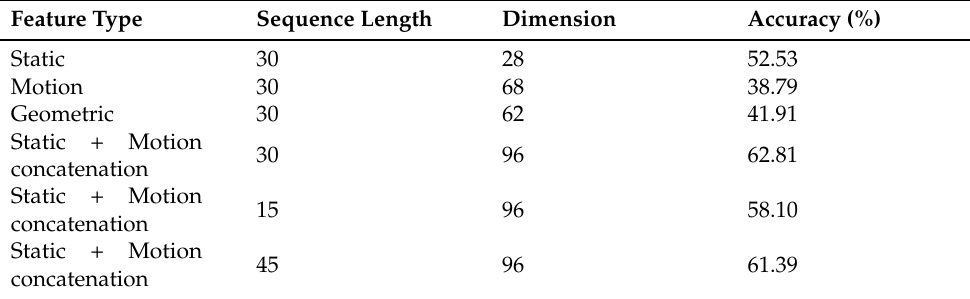
Table 2. Evaluation of JHMDB-1-GT with different types of feature combinations.